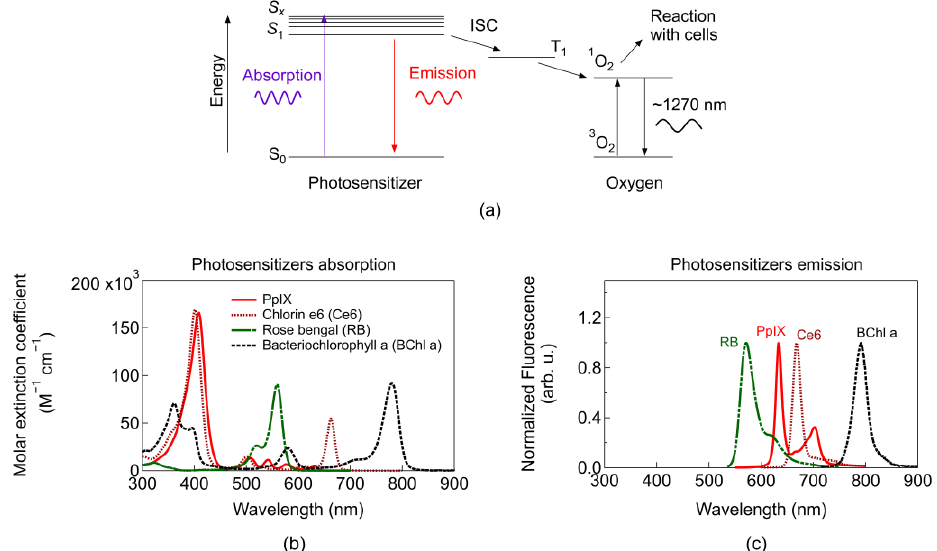
Figure 2. ( a ) Simplified Perrin–Jablonski diagram including PDT mechanism of action (ISC: Inter- system crossing). Each arrow indicates an energy conversion process (for simplicity not all possible conversions are depicted). Emission corresponds to the fluorescence of the PS and the 1270 nm emission from the singlet oxygen phosphorescence. ( b ) Molar extinction coefficient for absorption. ( c ) Fluorescence emission of typical PSs (data taken from [33,34]). Solvents used for measurements: chloroform for PpIX, toluene for Bacteriochlorophyll a, ethanol for rose bengal and chlorin e6. Additional parameters for common PSs, and PS targeting two-photon absorption can be found in pp. 32–36 [35,36], and [21], respectively.